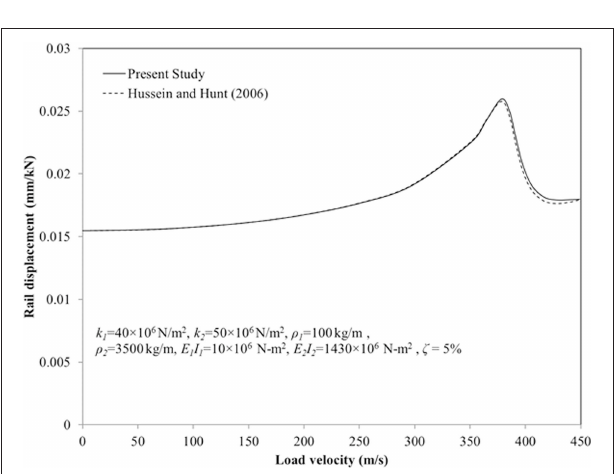
FIGURE 3 | Validation.